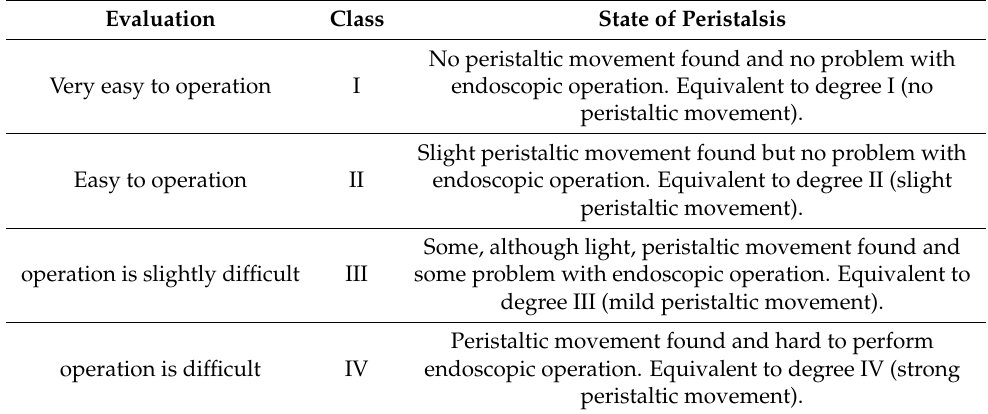
Table 1. Modified NIWA